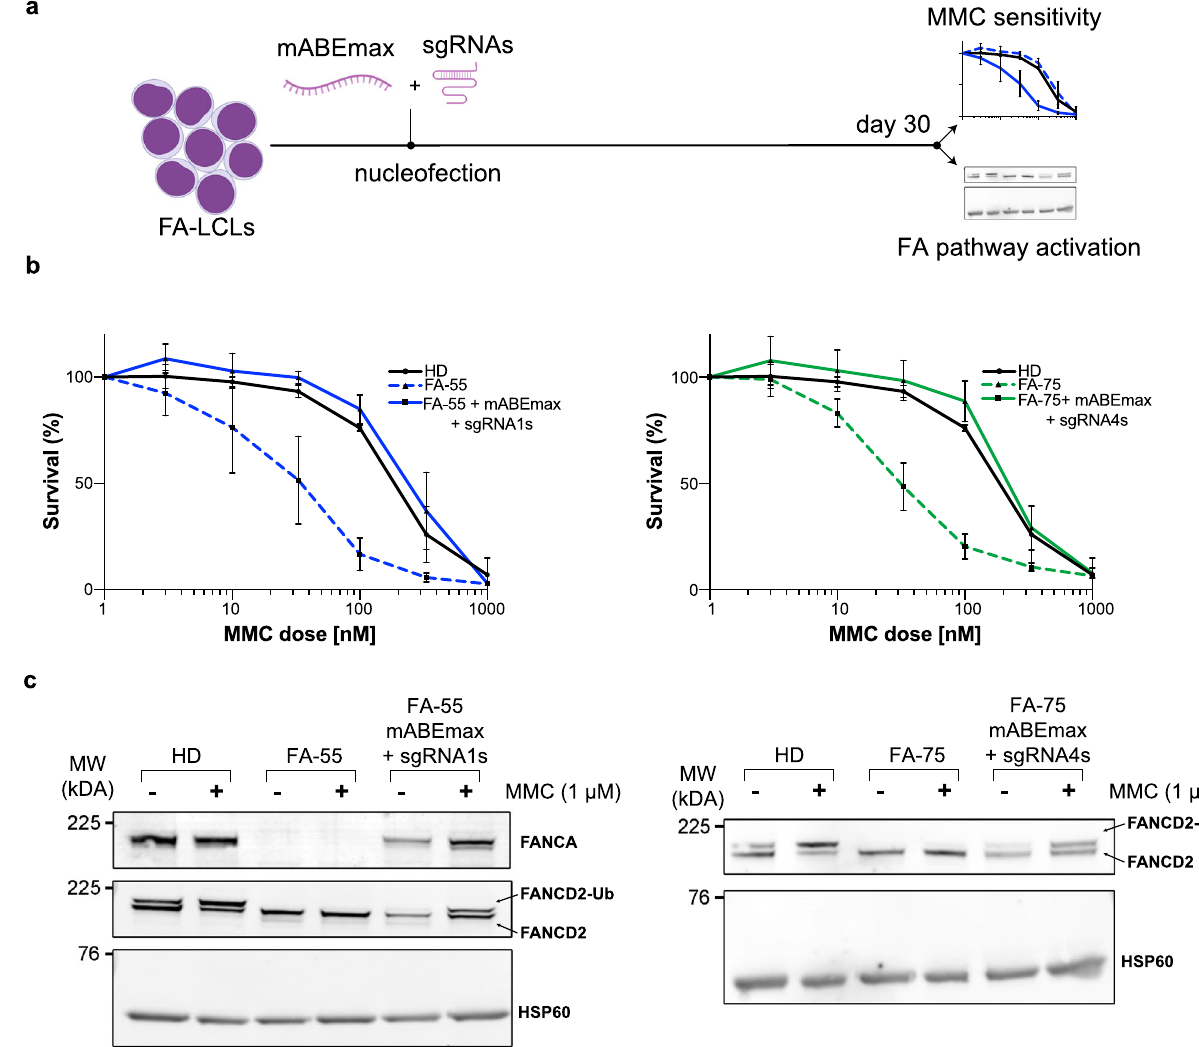
Fig. 2 | Base editing successfully reverts classical FA phenotypes. a Schematics of experimental design to edit FA-55 or FA-75 LCLs. Cells were edited with base editor mRNA and synthetic gRNA and grown for 30 days in culture. Editing ef fi - ciencies were assessed by amplicon NGS, as shown in Fig. 1c. (Created with BioR- ender.com). b MMC resistance of edited FA-A LCLs. Black line indicates healthy donor (HD) LCL response to increasing doses of MMC. Dashed blue or green lines represent FA-55or FA-75 LCLs, respectively. Solidblue or green linesrepresent FA-